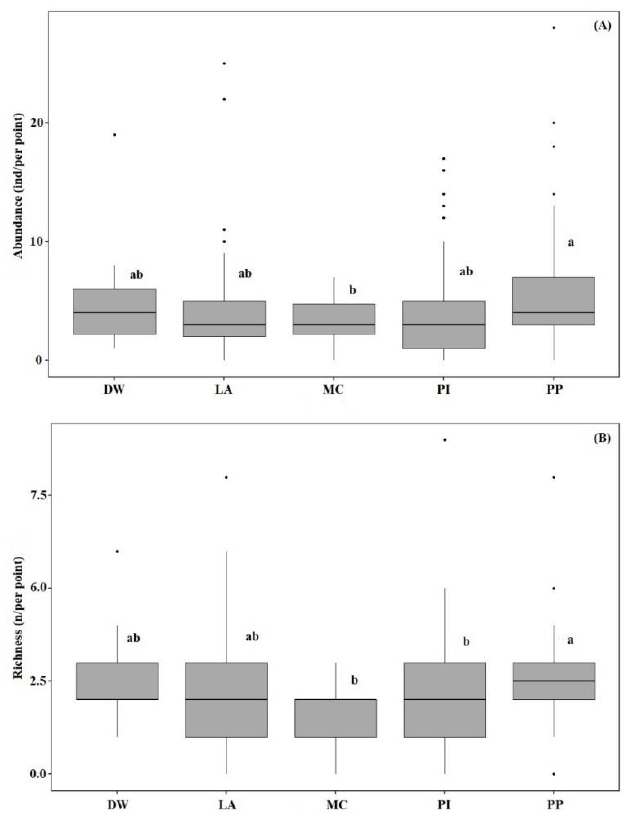
Figure 3. Analysis of variance (ANOVA) for abundance ( A ) and species richness ( B ) of birds in the number of birds per point among selected habitats. Forest types are deciduous woodland (DW), larch (LA), pine (PI), pine plantation (PP), and mixed conifer (MC).